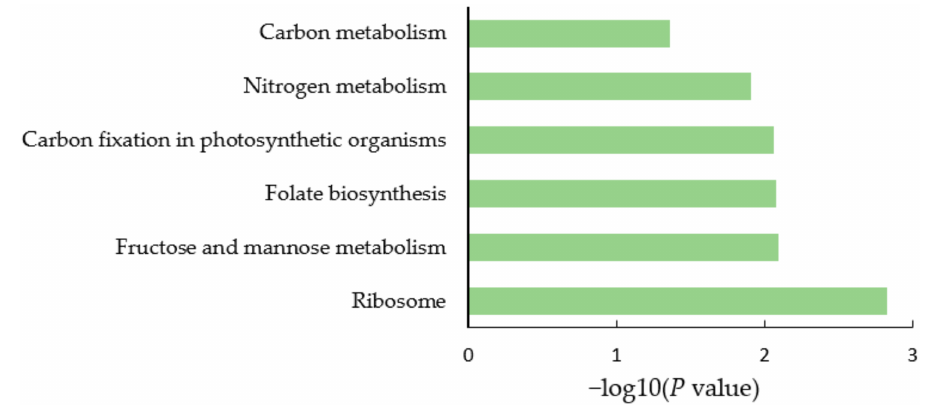
Figure 5. KEGG pathway of the DEPs in soybean rhizobia after nitrogen